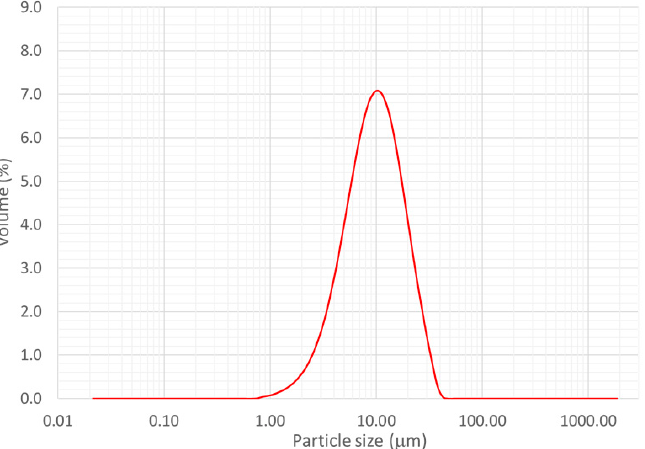
Figure 1. Diagram of the powder diameter repartition of the initial mix FeCrAlMnMo showing the grain size of the commercial mono-elementary powder after mixing.